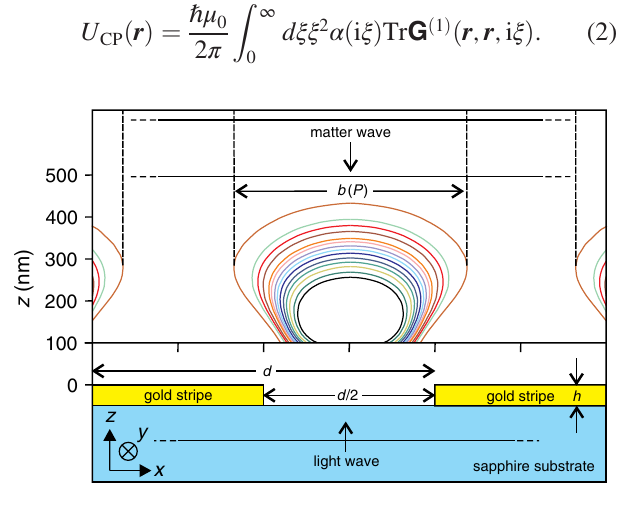
FIG. 2 Geometry of the metal grating. Approximately 200 gold stripes with h ¼ 50 nm height and 500 nm width are deposited on a sapphire substrate and form a grating with a d ¼ 1 μ m period. A laser beam impinges under an angle of θ ¼ 35 . 50 ° from the sapphire substrate onto the interface to vacuum (respectively, gold) with its k vector in the ð y; z Þ plane. The laser beam is internally reflected and generates an evanescent wave. The combination of the repulsive potential due to the evanescent wave with the Casimir-Polder interaction forms a FIG. 1 Simulation of the combined potential landscape, in- potential landscape above the grating. The colored lines (black to cluding the evanescent-wave potential and Casimir-Polder land- brown, corresponding to laser powers P ¼ 120 , 126, 133, 138, scape as calculated from Eqs. (1) and (2) for a laser power of P ¼ 211 mW. The repulsive evanescent-wave potential is gen- 144, 151, 156, 162, 169, 174, 187, 198, 211, 247 mW) are simulations of equipotential lines using exact theory based on erated by a laser beam that is reflected by the total internal Rayleigh decompositions for a 87 Rb atom moving towards the reflection in the substrate. The gold stripes weaken the intensity of the evanescent wave and thus modulate the strength of the surface with velocity v ¼ 3 . 4 cm = s. From those, we deduce the repulsion. The attractive Casimir-Polder potential reaches its width b ð P Þ where atoms are reflected. The two horizontal lines at maximum value above the gold stripes and further increases this the top represent the incoming matter wave and are drawn at a modulation. At a distance of z ¼ 200 nm, the potential is laterally distance given by the de Broglie wavelength λ 135 nm, with atomic mass m ¼ 14 μ K. modulated with an amplitude of Δ E=k B